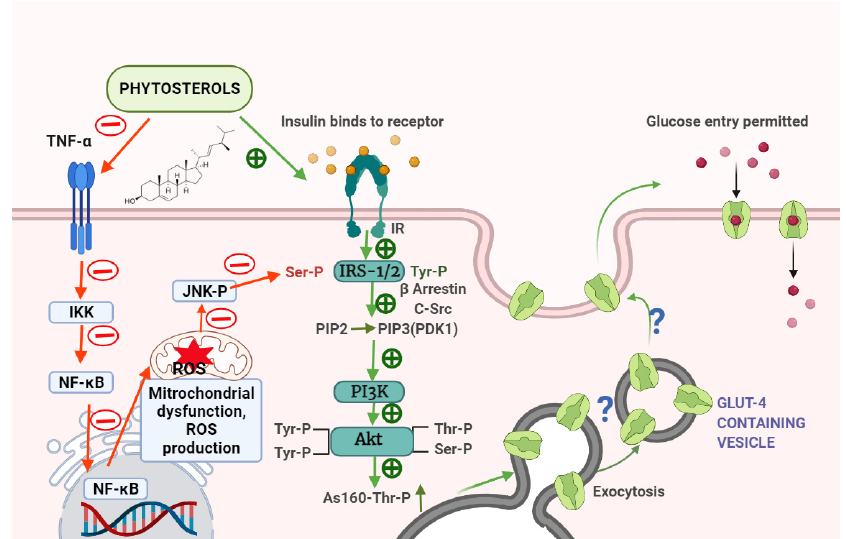
Figure 5. Schematic mechanism of plant sterols regulating insulin signalling and inflammation. The mechanism of action of phytosterol is illustrated in the figure based on the literature available. As phytosterol is a potent antidiabetic, it enhances insulin signalling molecules, such as IR, IRS 1/2, PI3K, Akt, and AS160, which promotes GLUT4 synthesis and glucose absorption. There is still a lack of research on the effects of phytosterols on the GLUT4 translocation pathway (denoted as ?). Phytosterol also suppresses inflammatory events by inhibiting the IKK/NF-kB and c-Jun-N-terminal kinase (JNK) signalling pathways. Plant sterol-facilitated activation is indicated by a green plus symbol. The red circle denotes phytosterol’s inhibitory effect on bothinsulin signalling and inflammation. Insulin sensitivity varies according to the target tissue. Skeletal muscle is more insulin-sensitive than liver and adipose tissue. For example, insulin resistance in skeletal muscle often precedes insulin resistance in the liver and adipose tissue in the early stages of T2DM, and it can also include abnormal metabolism in other tissues. Because IR contact and activation regulate physiological insulin signalling, which causes structural changes and autophosphorylation, culminating in the recruitment and phosphorylation of intracellular proteins such as insulin receptor substrates (IRS) and Sh2-containing collagen-related protein (Shc). IRS proteins stimulate the PI3K-Akt pathway, while Shc activates Ras-MAPK pathway. Phosphoinositol 3-kinase (PI3K) is activated by IRS proteins, which results in the synthesis of phosphatidylinositol 3,4,5-triphosphate (PIP3), a second messenger that recruits and stimulates 3-phosphoinositide-dependent protein kinase-1 (PDK-1). When PDK-1 is triggered, it phosphorylates Akt, which regulates glucose uptake by permitting the insulin-sensitive glucose transporter GLUT4 to translocate to muscle and fat cell membranes. Meanwhile, Akt has a role in lipid synthesis, gluconeogenesis, glycogen synthesis, and other insulin-related metabolic activities [67]. Insulin signalling is disturbed at multiple levels during insulin resistance, resulting in decreased glucose absorption in insulin-sensitive peripheral tissues, according to our earlier findings on the liver and peripheral organs. Insulin, insulin-like growth factors, and a variety of other growth factors are all members of the ligand-activated receptor family, which also includes the insulin receptor. It’s a tyrosine kinase-family transmembrane signalling protein. The antioxidant and hypolipidemic actions of